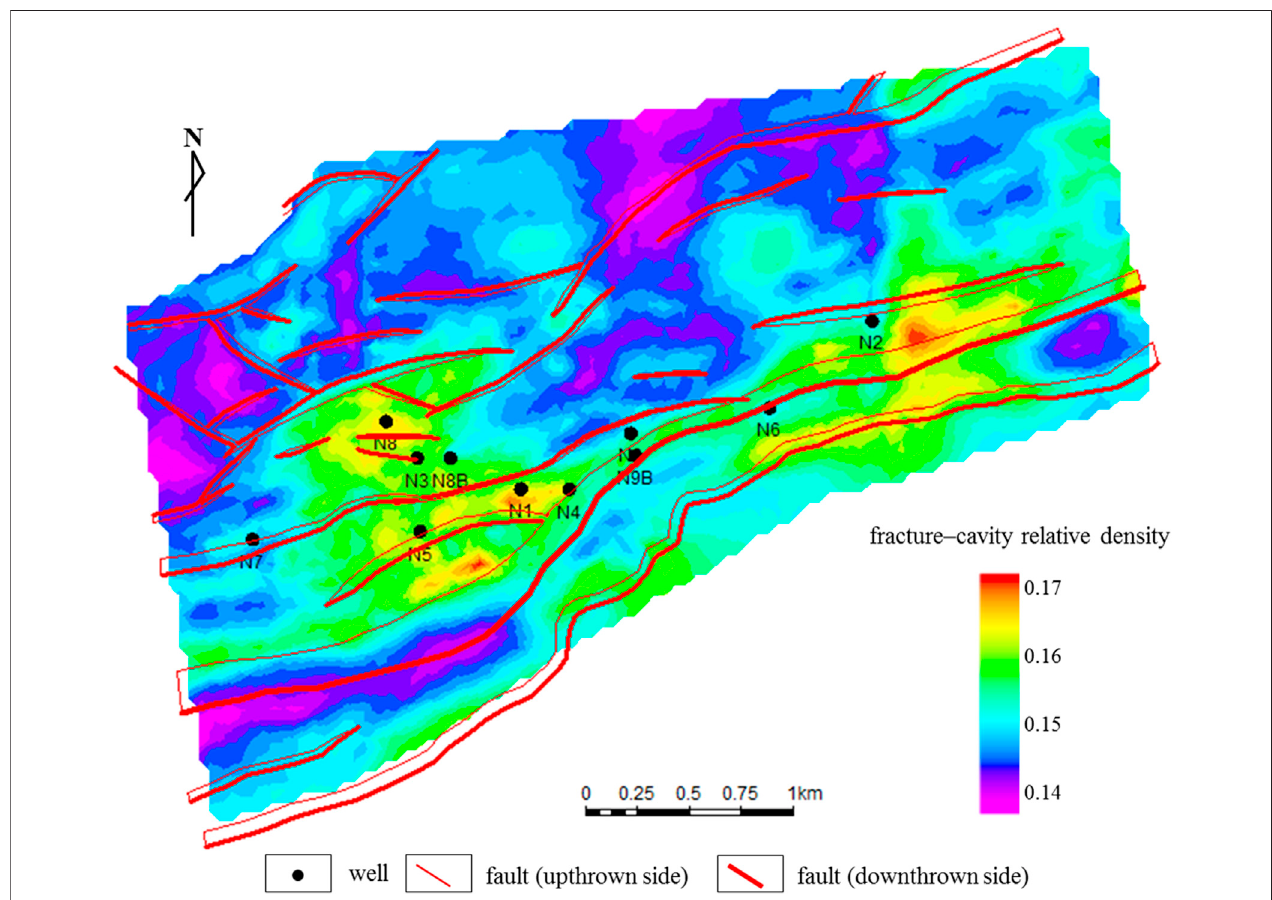
FIGURE 16 | Distribution prediction diagram of the fracture – cavity relative density in the Weizhou 1 – N oil fi eld.